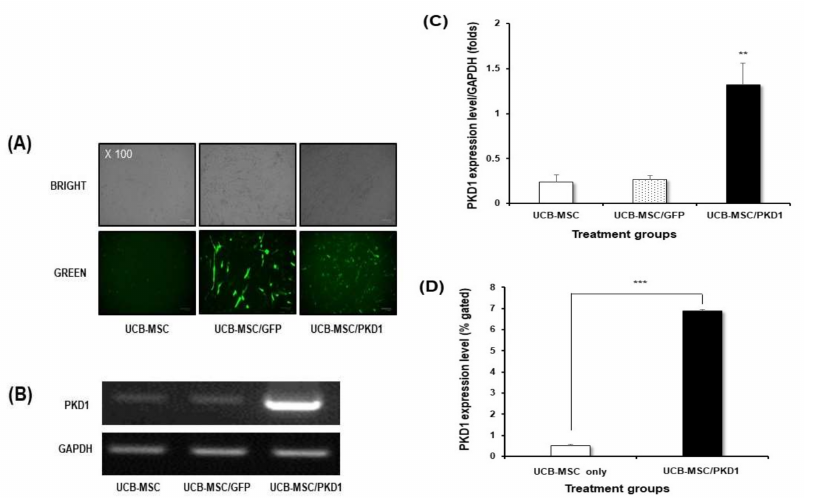
Figure 2. Validation of PKD1 expression in transcript and protein level by PKD1 -expressing GFP/lentiviral vector. ( A ) GFP expression in UCB-MSC transfected with PKD1 -expressing vec- tor. PKD1 expression ( B ) and quantitative data ( C ) in transcript level of PKD1 expressing UCB-MSC; ( D ) The expression of PKD1 at the protein level. Data shown represent the mean ± SD ( n = 3). ** p < 0.02 or *** p < 0.01 versus UCB-MSC only